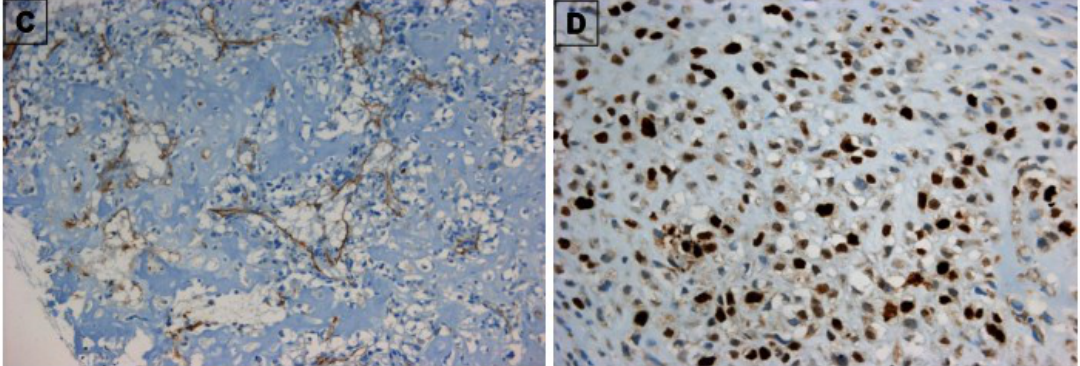
Figure 2. Cultured tumor endothelial cells from bone sarcoma. ( A ) Confluent tumor endothelial cells (TEC 1 line) stained with CD31, exhibiting the typical cobblestone structure (Panel A); ( B ) DAPI control staining; ( C ) Tumor endothelial cells TEC 1